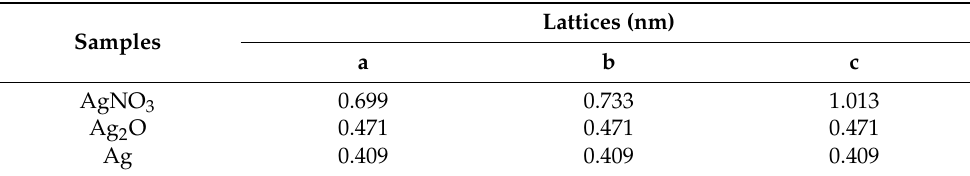
Table 5. Values of the lattice parameters of silver nitrate (AgNO 3 ), silver oxide (Ag 2 O), and silver